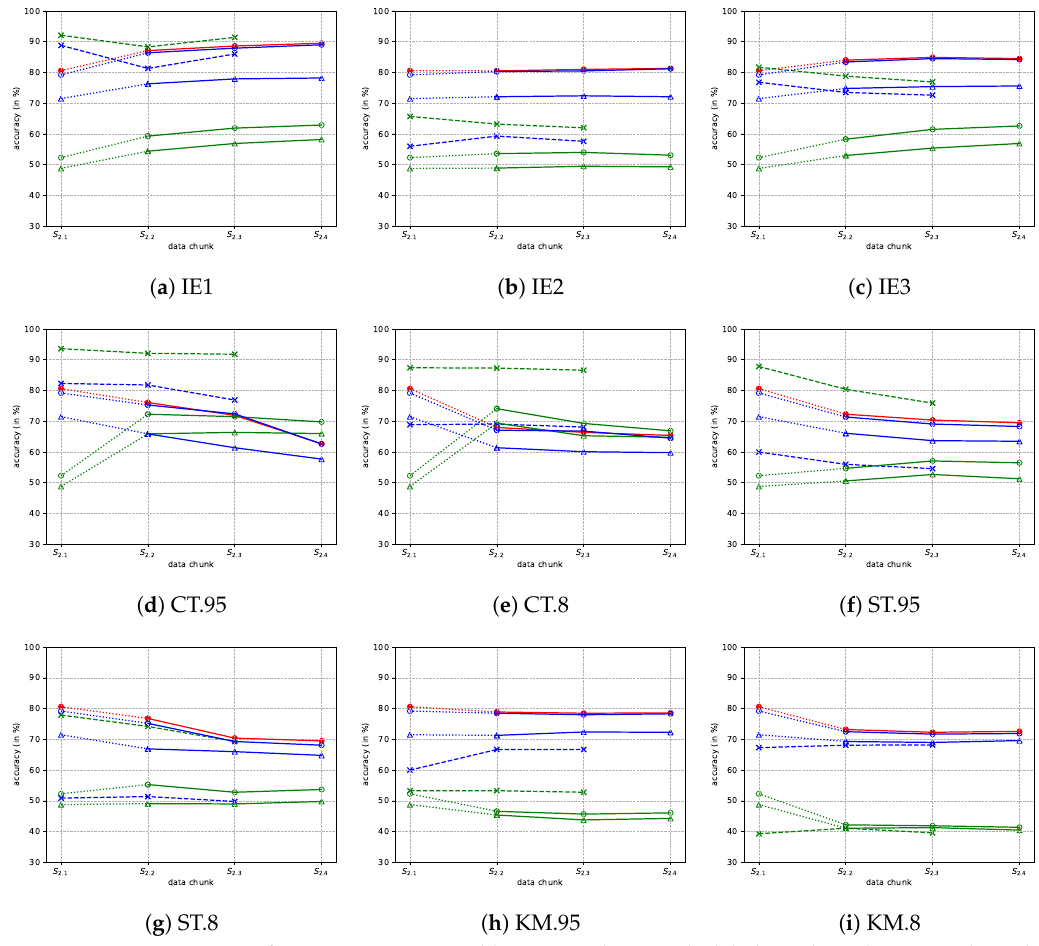
Figure 11. Accuracies of iterative incremental learning. The pseudo-labeling algorithm is conducted on S 2.1 , S 2.2 , and S 2.3 , while the classifier is re-trained incrementally at the end of S 2.1 , S 2.2 , and S 2.3 . The original classifier which is trained on S 1.1 is tested on S 2.1 , while the updated classifiers are tested on S 2.2 , S 2.3 , and S 2.4 . The fusion is based on the 2nd scheme. The marker definitions follow: • denotes fusion accuracy; ◦ , (cid:77) , and ∗ denote the frequency-domain filter, classifier, and pseudo-labeling accuracy, respectively; ◦ , (cid:77) , and ∗ denote the time-domain filter, classifier, and pseudo-labeling accuracy,